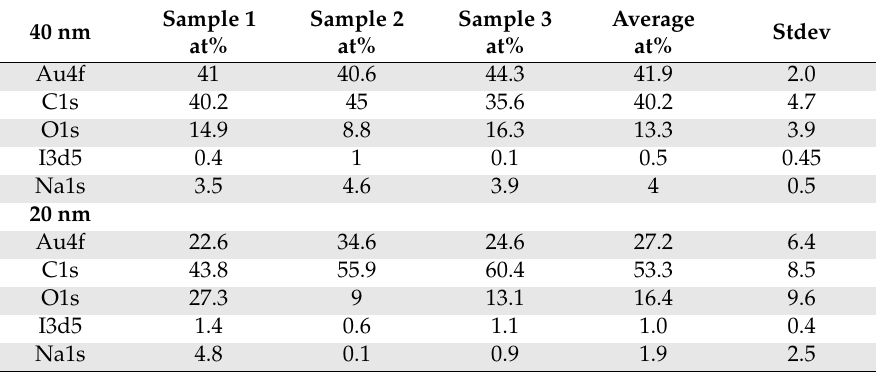
Figure 3. XPS survey spectra of the UTGFE (20 nm) and GE (40 nm). Table 1. The atomic concentrations (at%) of detected elements are given in the table.